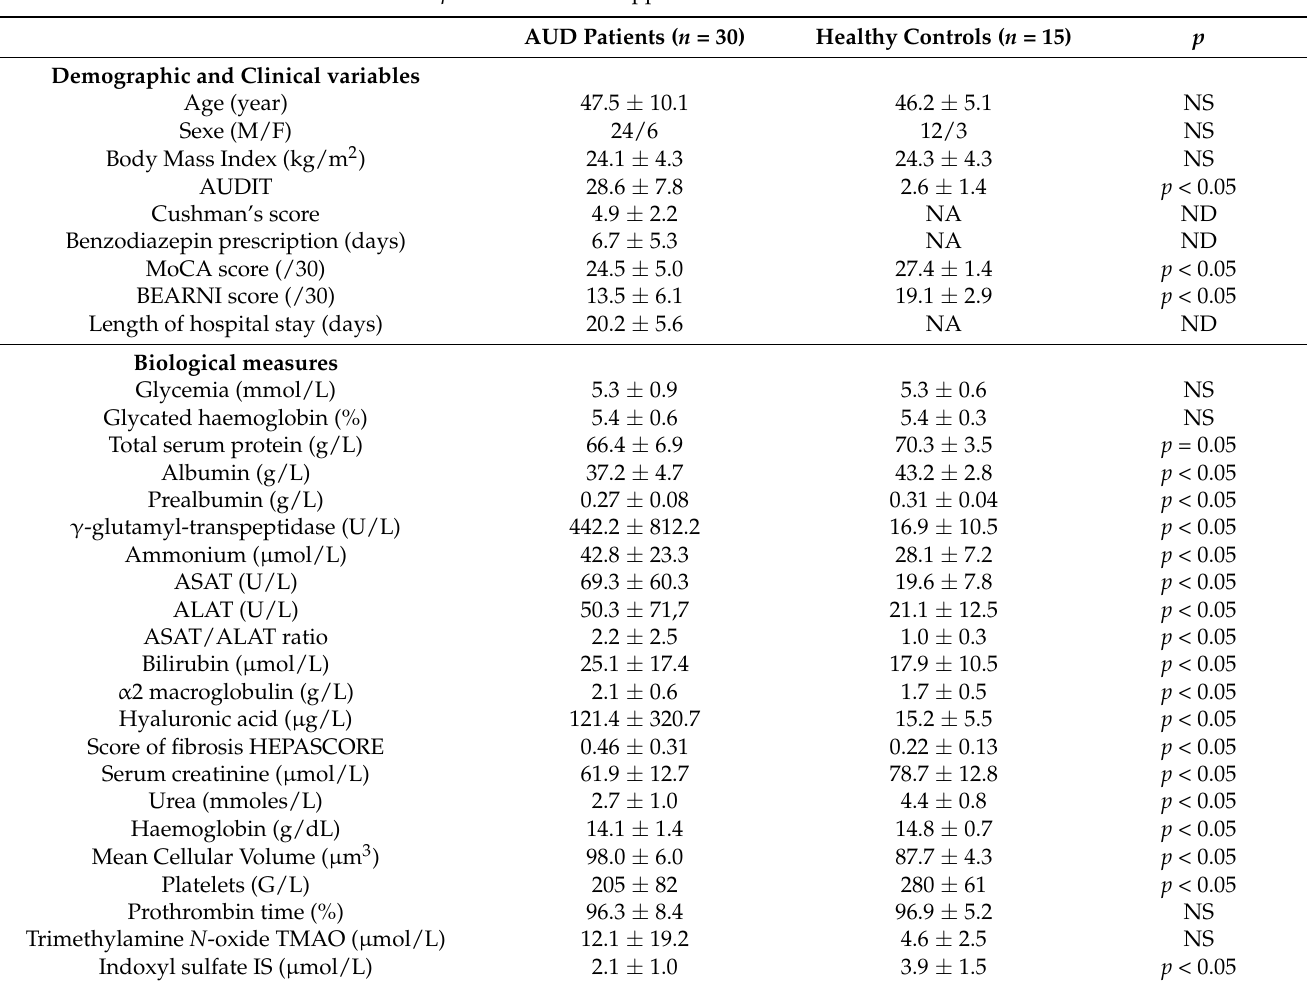
Table 1. Demographic, clinical, neuropsychological and biological data observed in AUD patients and HC. Data are expressed as the mean ± standard deviation. AUD: Alcohol Use Disorder. HC: Healthy Controls. AUDIT: Alcohol Used Disorders Identification Test. MoCA: Montreal Cognitive Assess- ment. BEARNI: Brief Evaluation of Alcohol-Related Neuropsychological Impairments. Significantly different at p < 0.05. NA: Not applicable. ND: Not